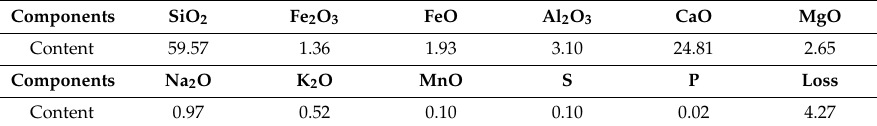
Table 4. Chemical composition of the reducing slag / wt %.